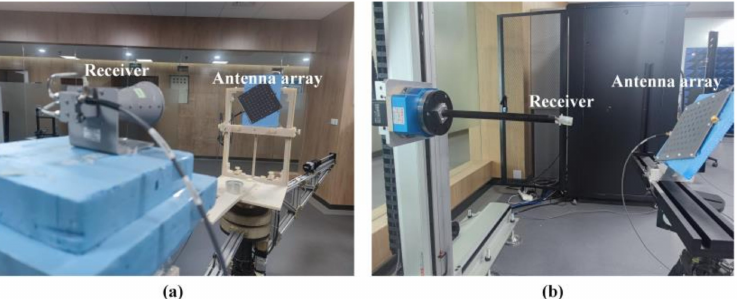
Figure 11. Experimental setup for ( a ) far-field and ( b ) near-field